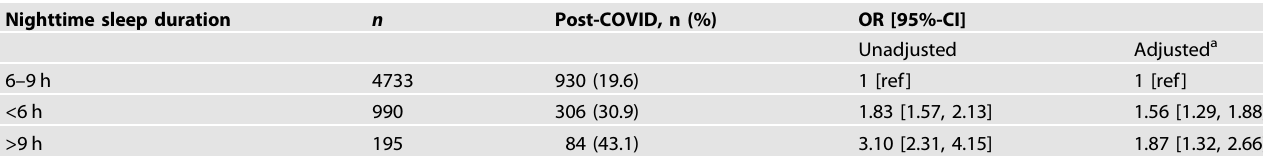
Table 2. Association of habitual nighttime sleep duration with post-COVID among those receiving two mRNA vaccinations. Nighttime sleep duration n